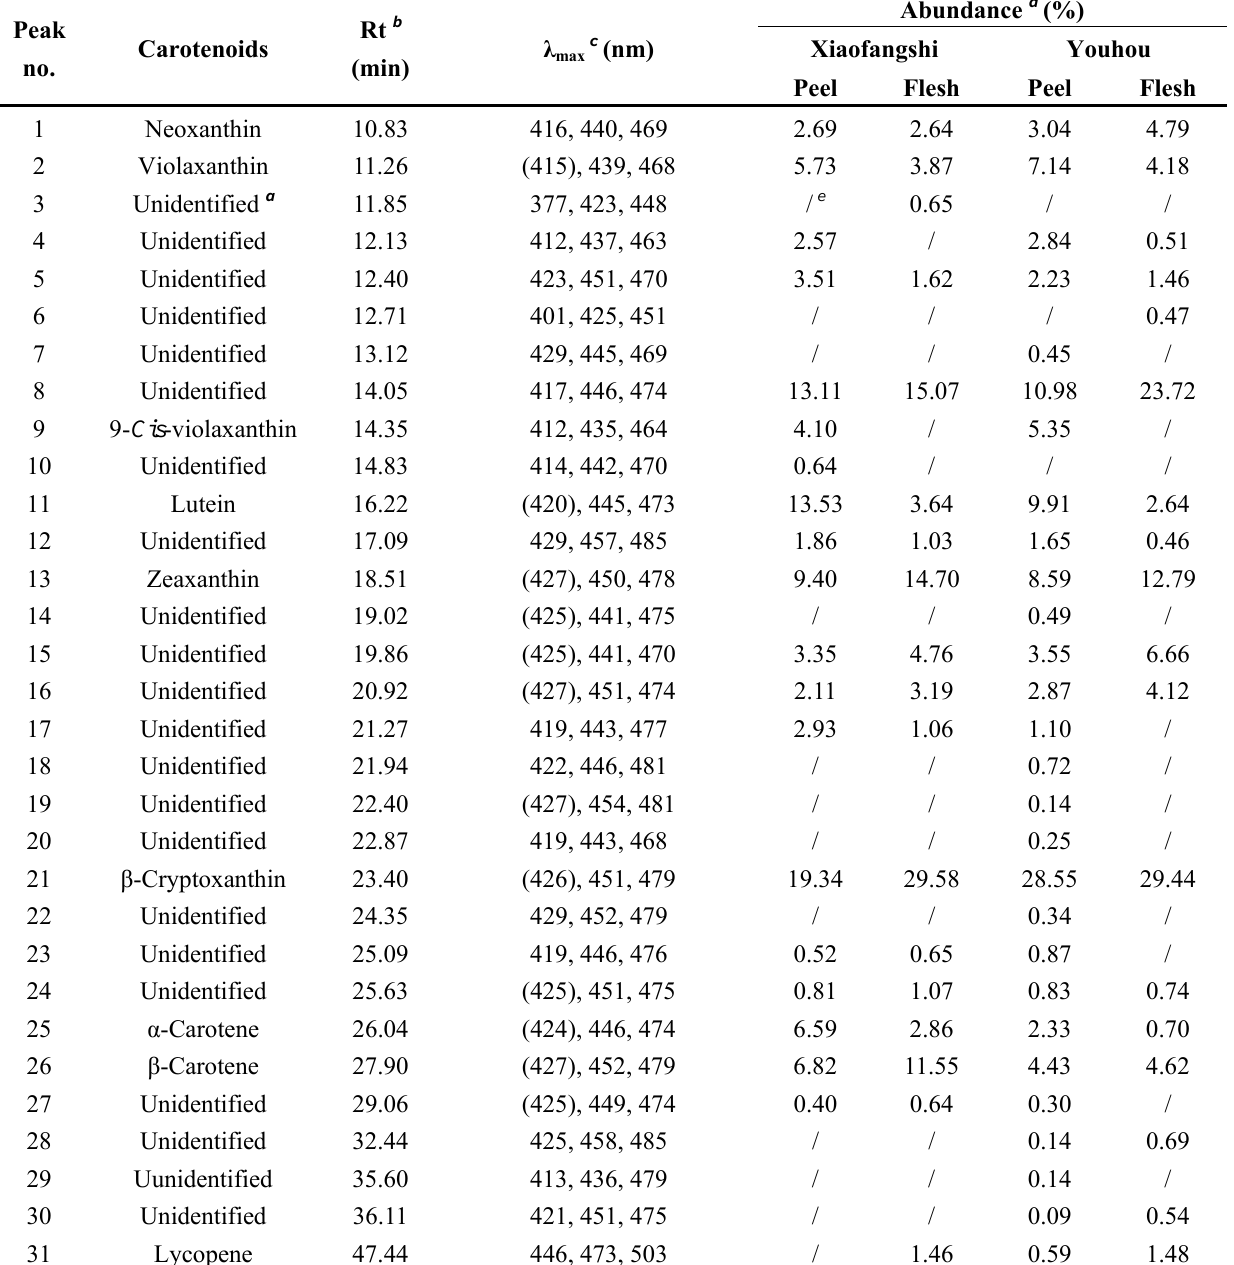
Table 2. Separation and identification of carotenoid components in different tissues of the persimmon fruits cv. ‘Xiaofangshi’ and ‘Youhou’ by high performance liquid chromatography with photodiode array detection.